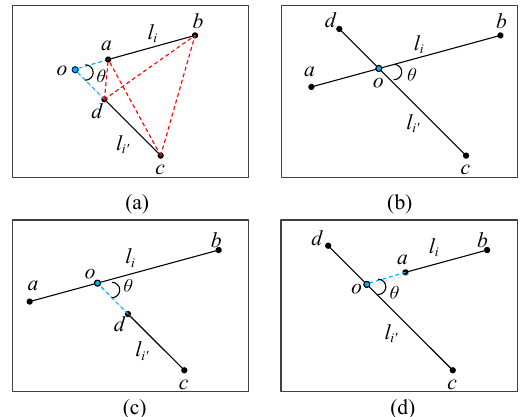
Figure 1. Four types of line-pairs. Endpoints of both line segments are a , b , c , and d , respectively; the intersection of the two lines is o , and the intersection angle is θ